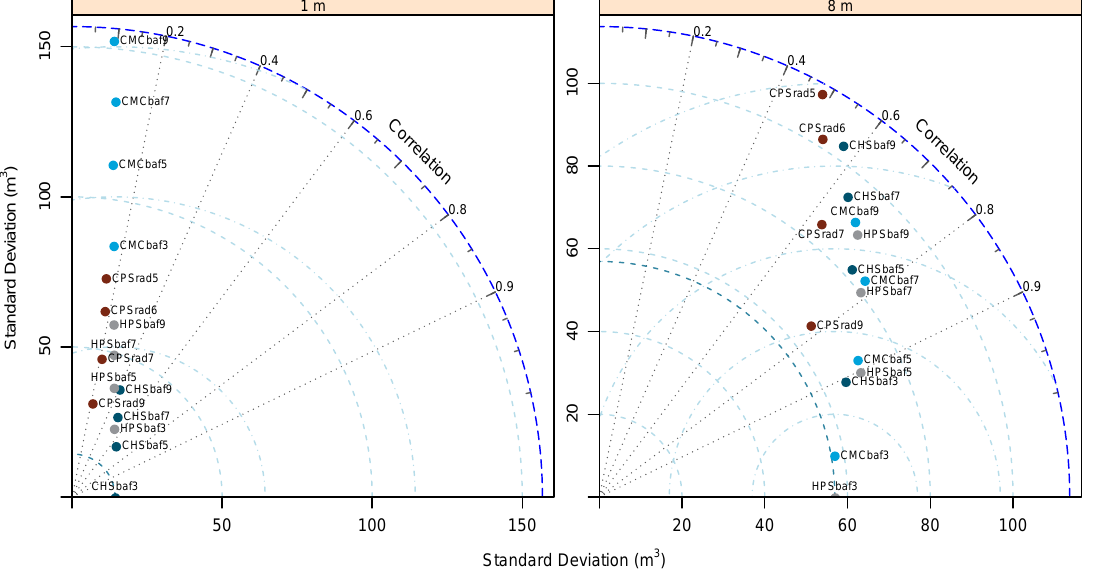
, j = 1,4. These panels include j